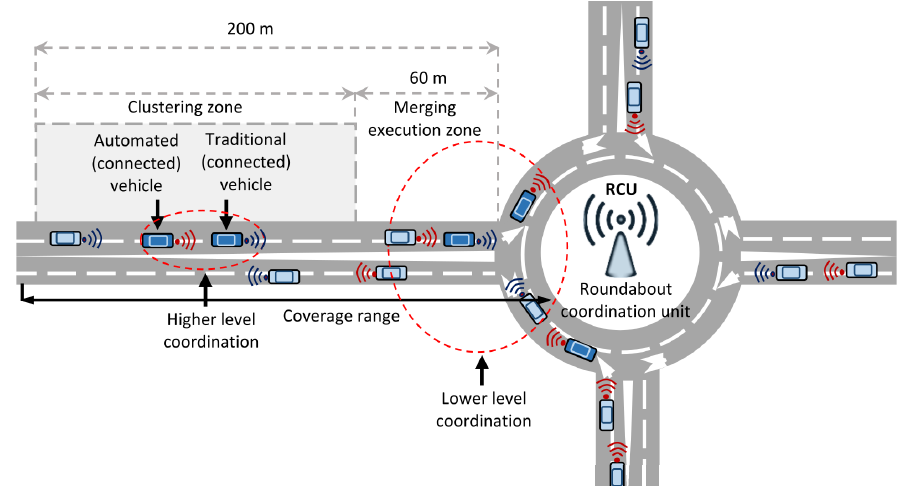
Figure 1. The proposed bi-level roundabout control system (RCS). The environment contains au- tomated and traditional connected vehicles. The RCU has two-way communication facility and coordinates automated vehicles at the higher and lower